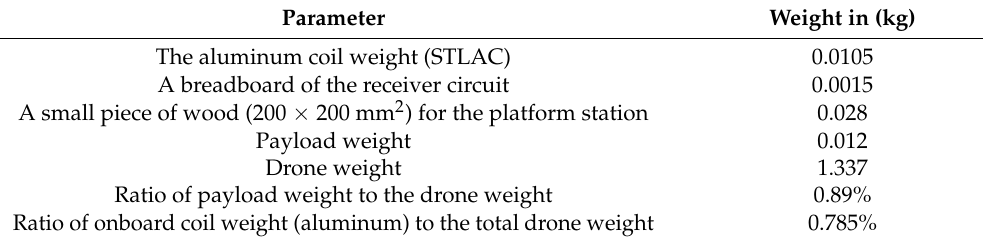
Table 5. Calculation of drone